Question: Give a one-sentence summary of this figure.
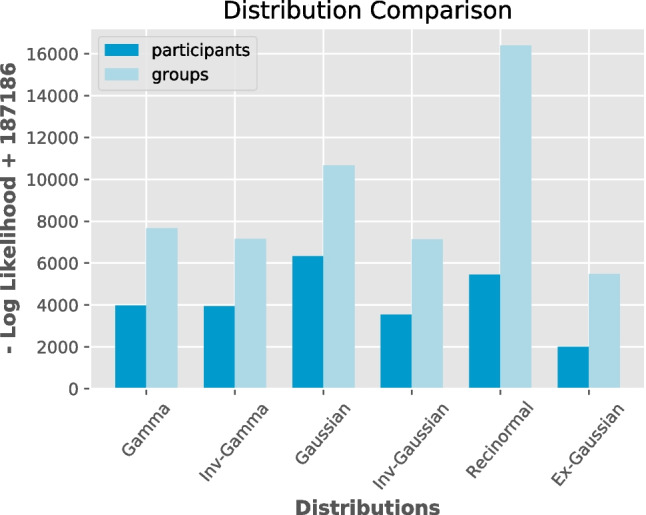
Answer: Distribution comparison using −log-likelihood score, lower is better. Distributions are fitted on individual participant’s data and on group-based data (all color group participants and all shape group participants). The best distribution is Ex-Gaussian, followed by inverse Gaussian